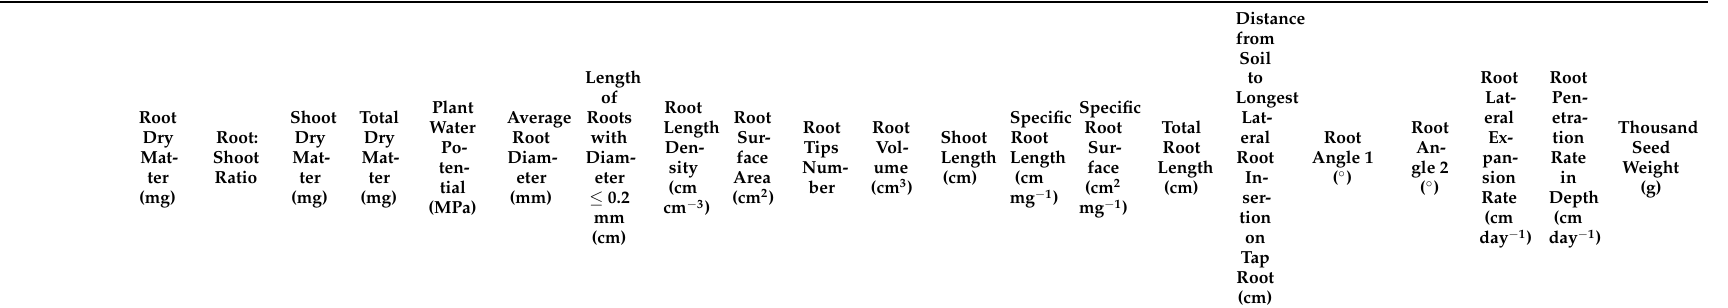
Table A4. Correlation between traits under well-watered